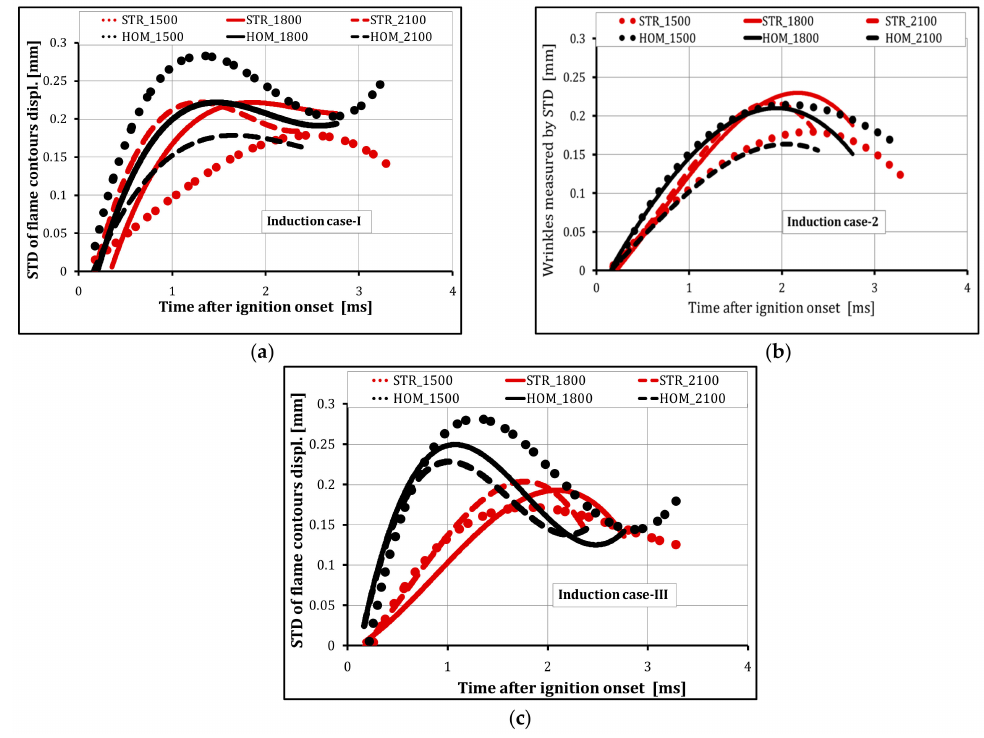
Figure 7. Flame wrinkles measurements for case 1, case 2 and case 3 inductions for stratified and homogeneous charge combustions at variable engine speeds. ( a ) Induction case I; ( b ) Induction case II; ( c ) Induction case